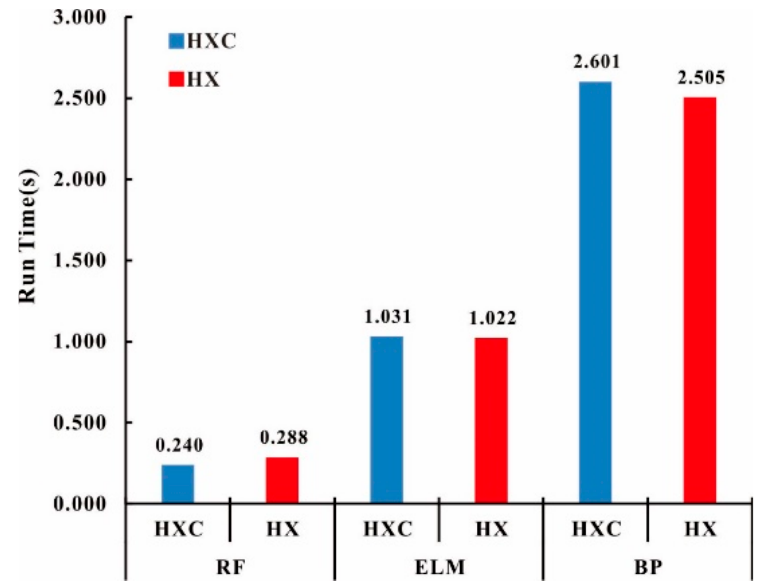
Figure 10. Run time of ML models using HXC and